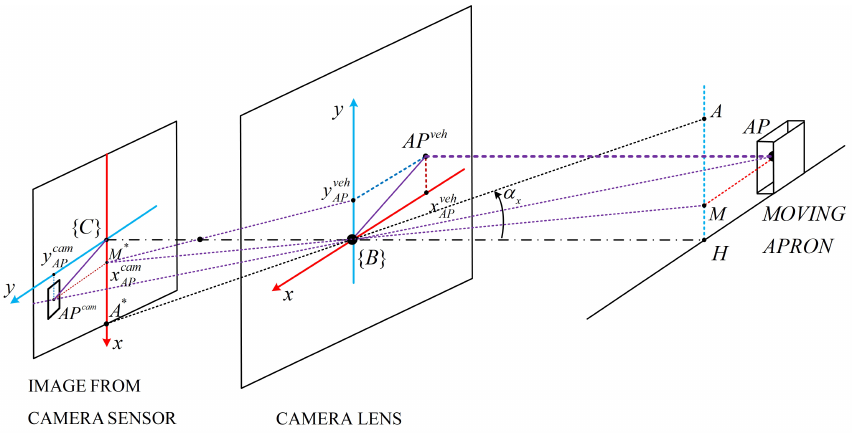
Figure 2. The position of the apron image in the camera-sensor-fixed coordinate ( { C } ) and the apron position in the quadcopter’s body-fixed coordinate ( { B }